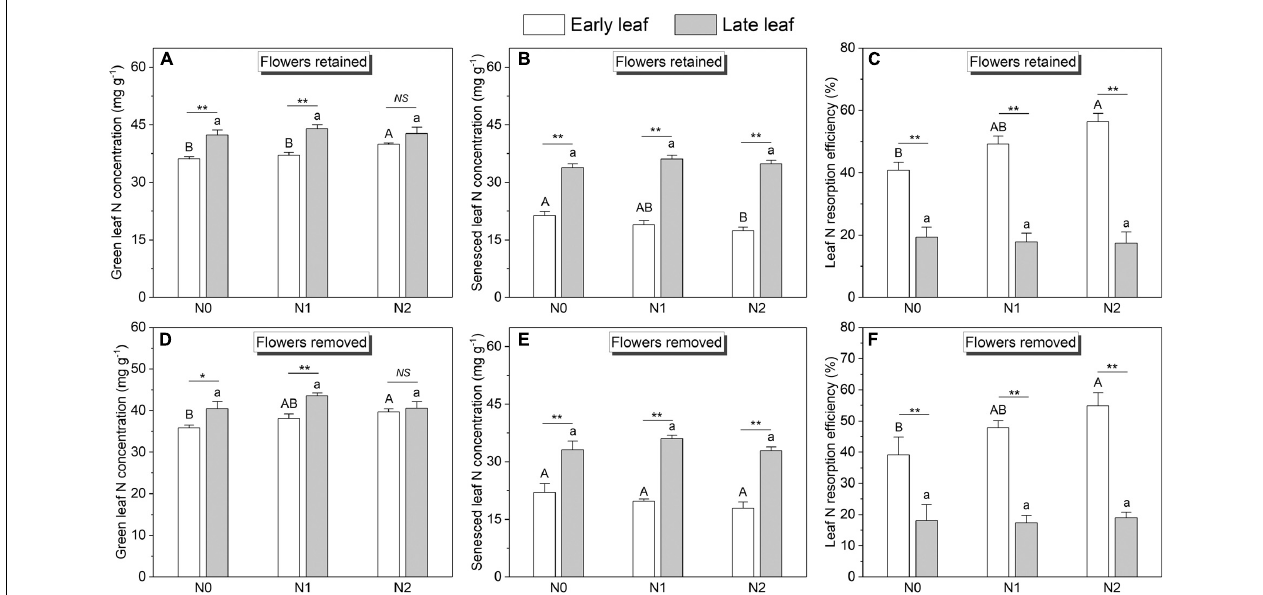
FIGURE 4 | N concentrations and resorption efficiencies of the early leaves and late leaves at different N addition levels ( n = 11 for plants with flowers, n = 6 for plants with flower removal): N0 (control), with no N addition; N1, 56 g N per individual; N2, 112 g N per individual. Values are means ± SE. (A–C) Represent plants without sink decrease treatment (Flowers retained). (D–F) Represent plants with sink decrease treatment (Flowers removed). Bars labeled with different letters differ significantly (one-way ANOVA) between N addition treatments ( P < 0.05) for early leaves (upper-case letters, i.e., A, B) and late leaves (lower-case letters, i.e., a, b), respectively. * and ** indicate significant difference at P < 0.05 and P < 0.01 level respectively ( t -test) between the two leaves in a given